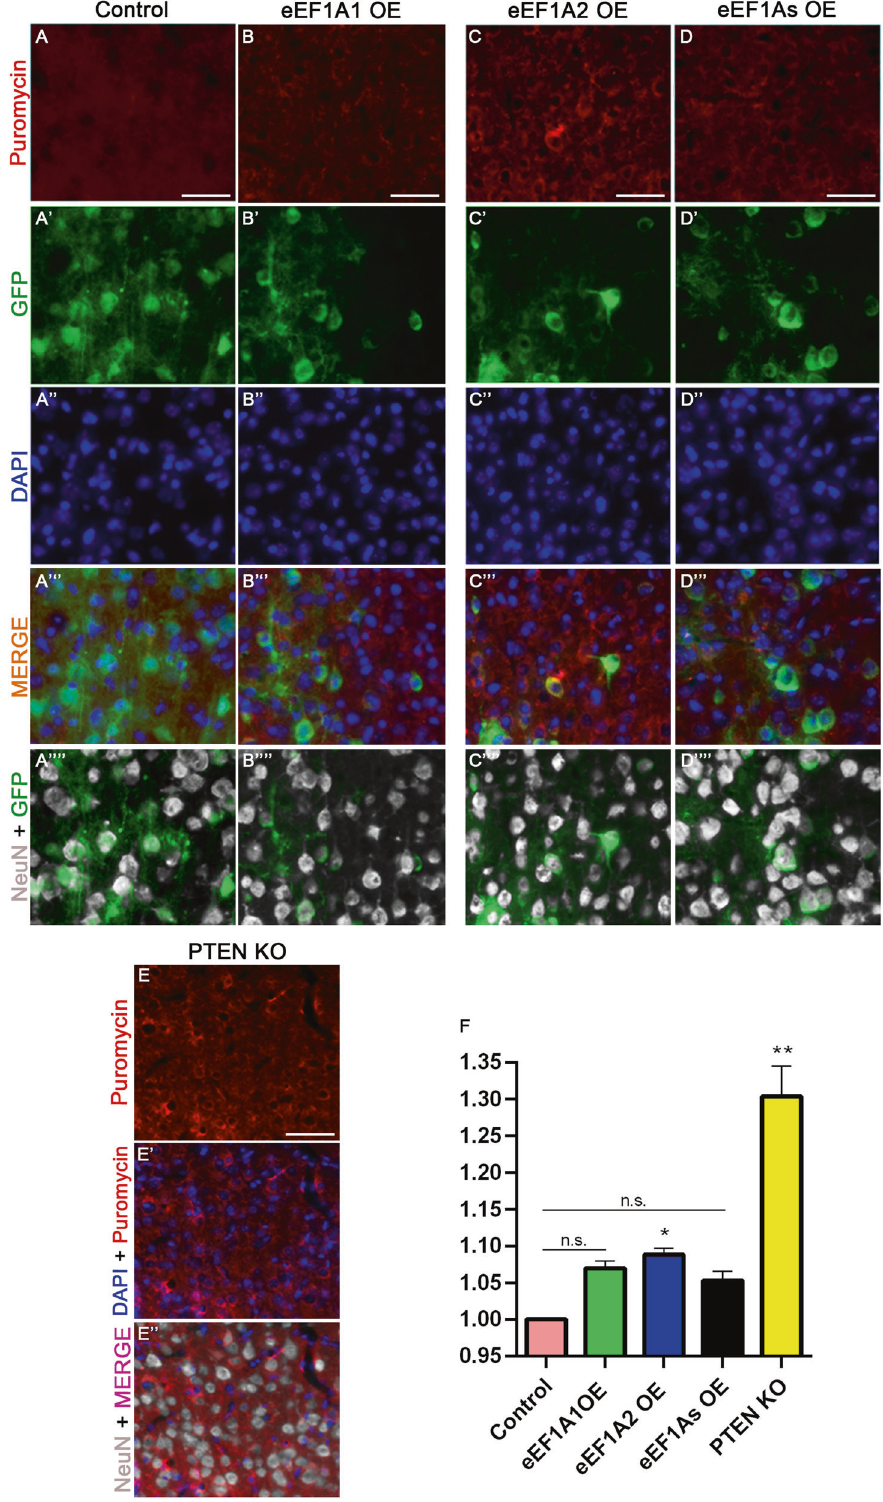
Fig. 2 Only eEF1A2 OE signi fi cantly increases protein synthesis. Representative images of puromycin, GFP (viruses), and NeuN staining at the layer V of the right sensorimotor cortex of injured control mice (AAV-GFP injection) ( A – A ”” ); injured eEF1A1-overexpressing (OE) mice ( B – B ”” ); injured eEF1A2-OE mice ( C – C ”” ); injured eEF1As-OE mice ( D – D ”” ); and injured PTEN cKO mice serving as a positive control ( E – E ” ). F Quanti fi cation of puromycin immunoreactivity. Scale bars: 50 μ m. 4 mice per each genetic condition; 50 cells quanti fi ed per mouse. Stats: One-way ANOVA with Kruskal – Wallis Test. Bars show mean ± SEM. * p = 0.0239, ** p = 0.0011.